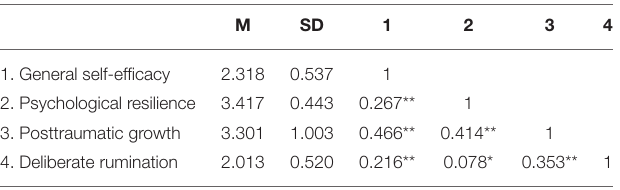
TABLE 1 | Means, SDs, and correlations of variables ( N = 881).